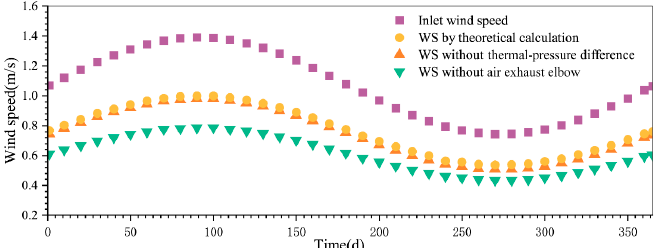
Figure 10. Variation law of the wind speed as a function of different influencing factors.